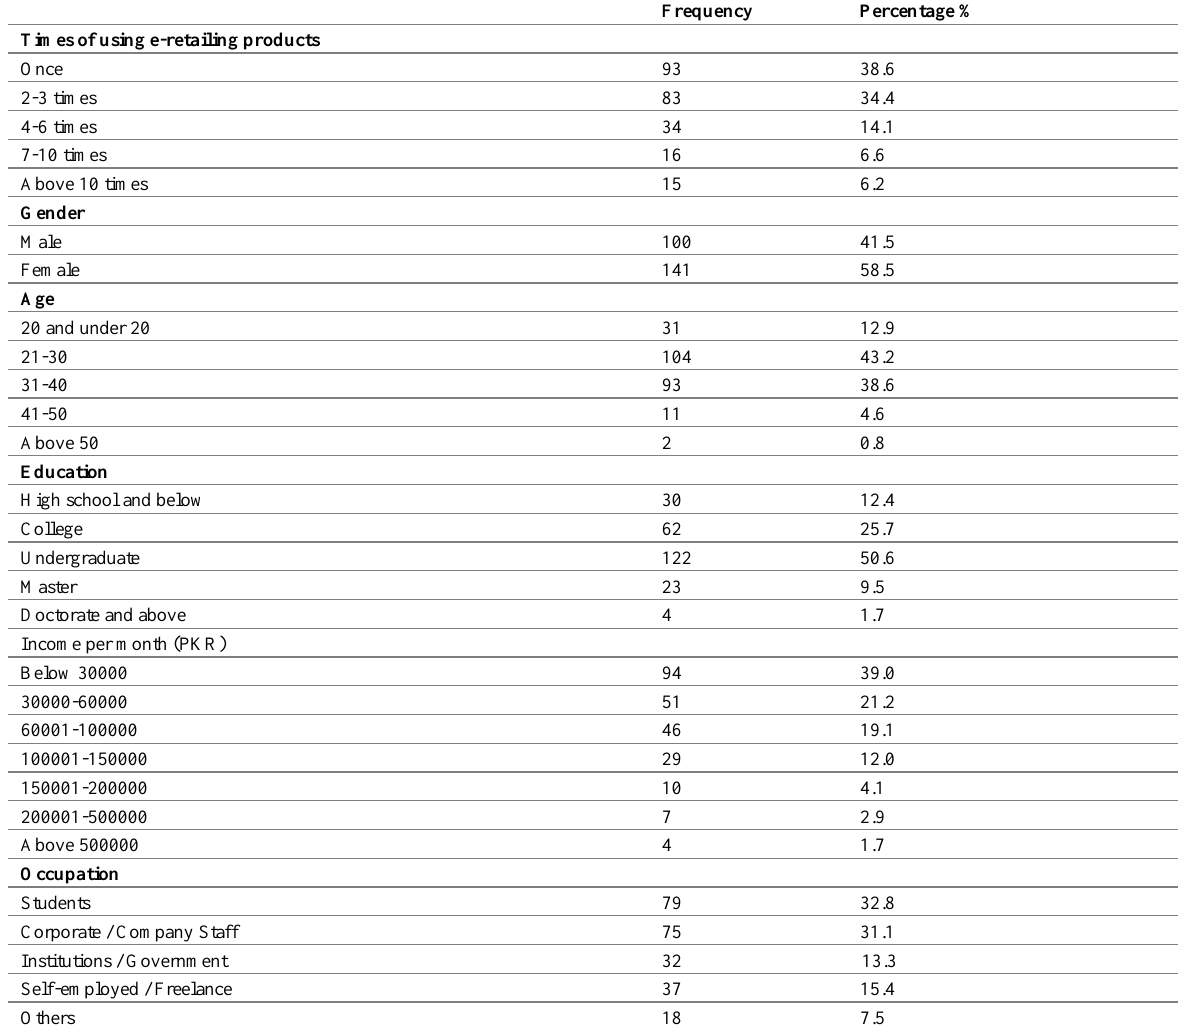
Table 1: Characteristics of the Respondents ( n =